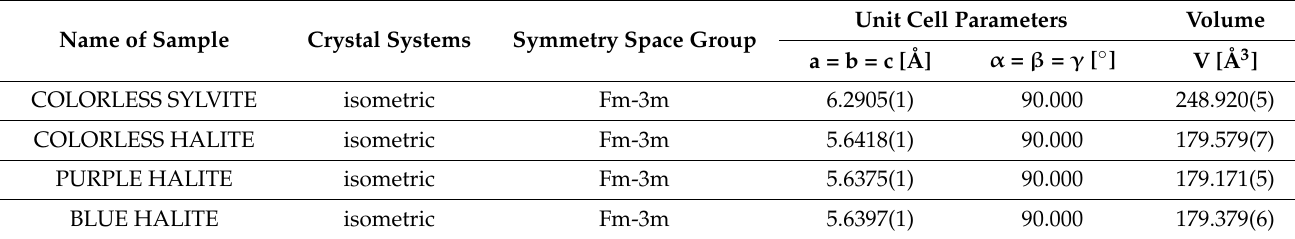
Table 3. Lattice parameters of minerals identified by the XRD method.